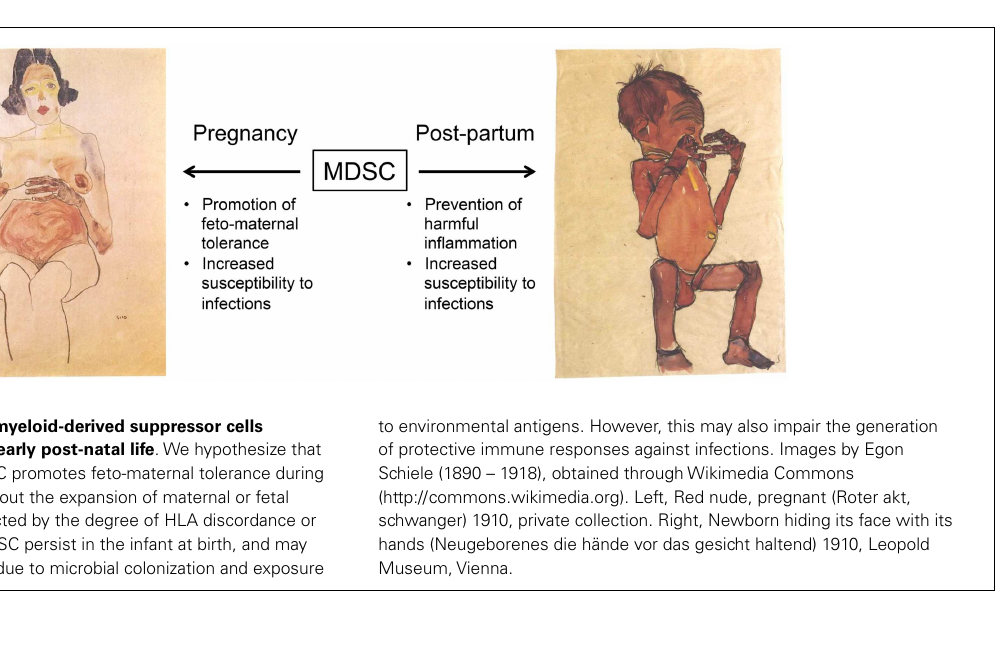
FIGURE 1 | Proposed roles of myeloid-derived suppressor cells (MDSC) during gestation and early post-natal life .We hypothesize that an increased frequency of MDSC promotes feto-maternal tolerance during gestation.Very little is known about the expansion of maternal or fetal MDSC, or how this may be affected by the degree of HLA discordance or other factors. High levels of MDSC persist in the infant at birth, and may suppress harmful inflammation due to microbial colonization and exposure